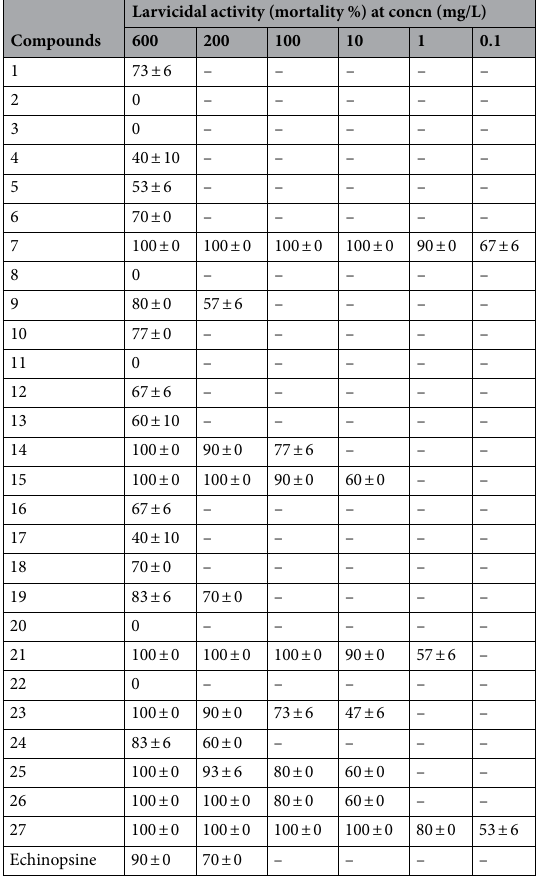
Table 2. Insecticidal activity of compounds 1 – 27 and echinopsine against Diamond Back Moth ( Plutella xylostella